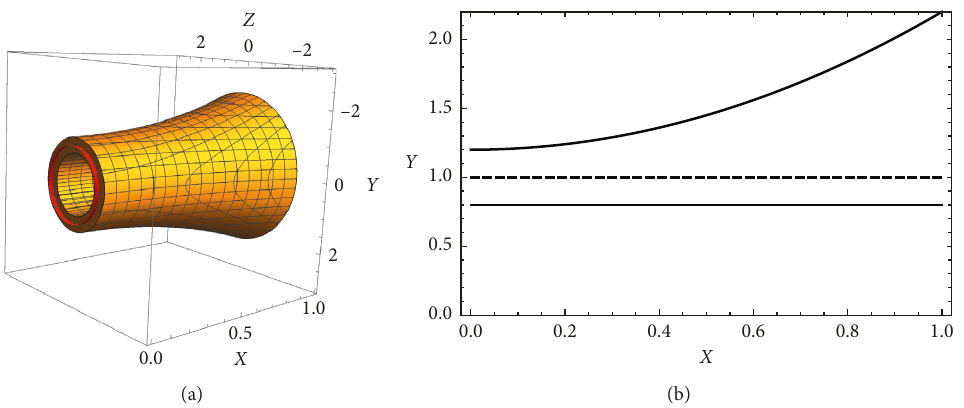
Figure 1: Shell of revolution with variable axial thickness; midsurface indicated with (a) red colour and (b) dashed line. (a) Shell of revolution. (b) Cross section; midsurface f ( x ) � 1 (dashed), lower surface f ( x ) − d 0 ( x ) and upper surface f ( x ) + d 1 ( x )